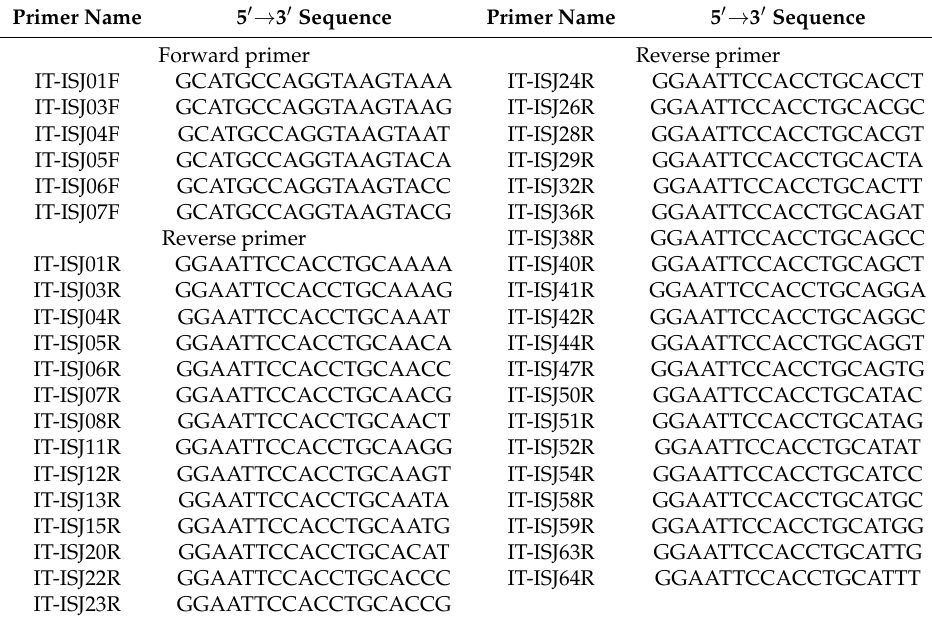
Table 7. IT-ISJ primer